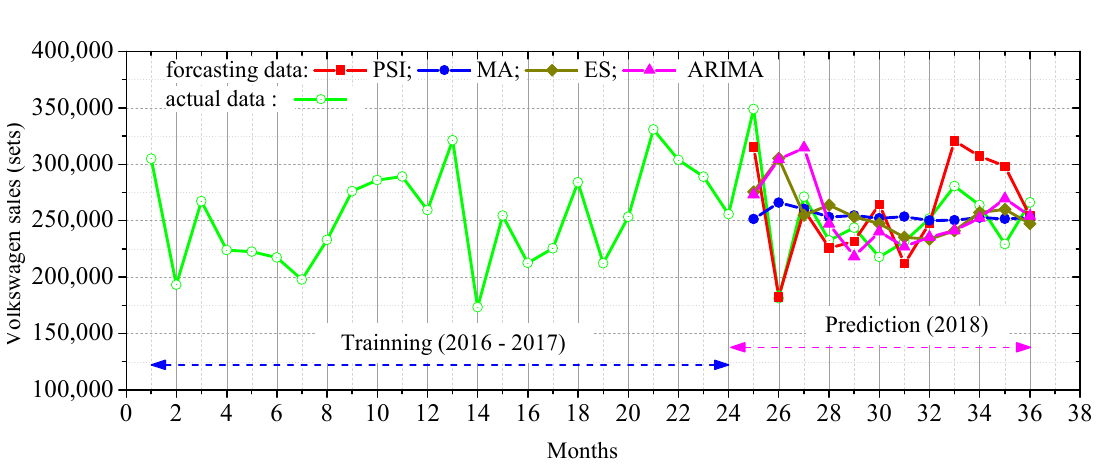
Figure 5. Time series pattern and prediction on the Volkswagen sales (VS) dataset.